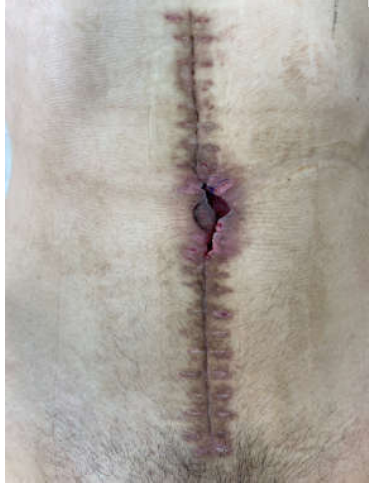
Figure 6. A view of the fistula site 12 days after the start of treatment.